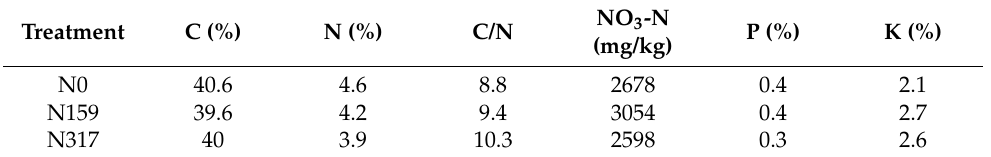
Table 4. Average contents of C, N, NO 3 -N, P and K in the crop of air-dried Chinese cabbage plants. Treatment